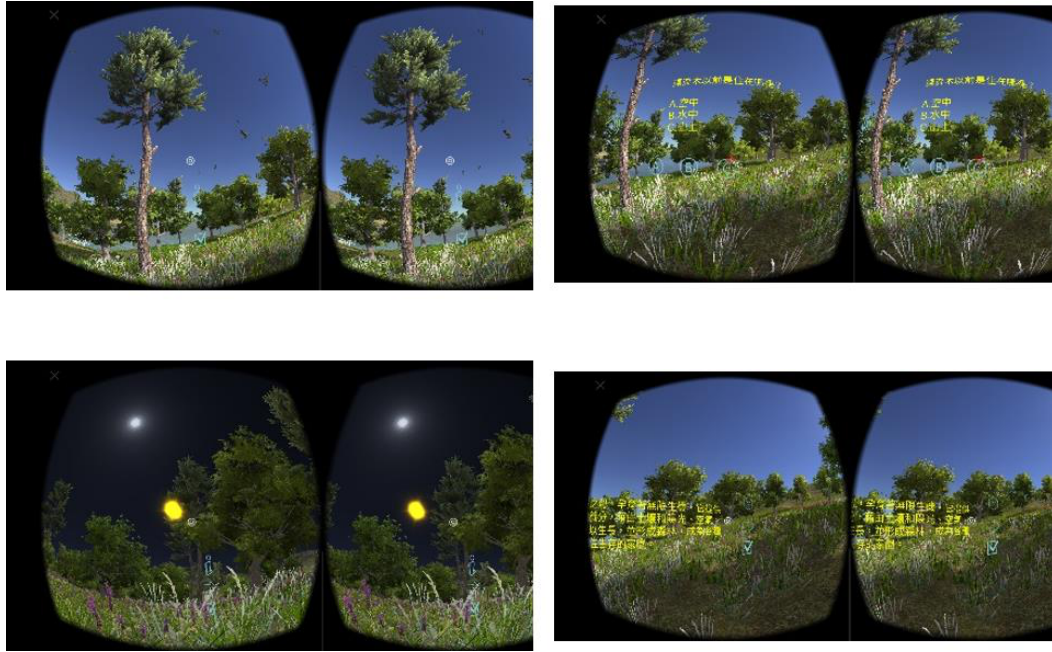
Figure 12. Views wearing VR helmets with a smartphone and an Android app to watch/play 3D VR content.